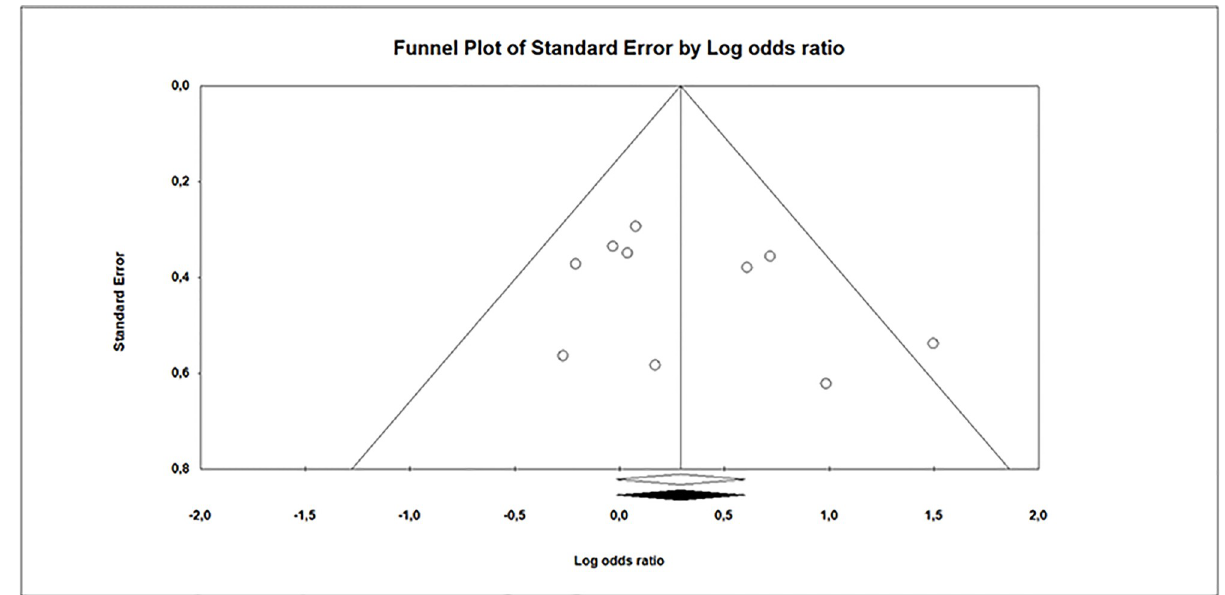
Fig 5. Funnel plot for pregnancy rates. Including the ’Trim and Fill’-method (black diamond), looking for missing studies (created with CMA Software [39]).